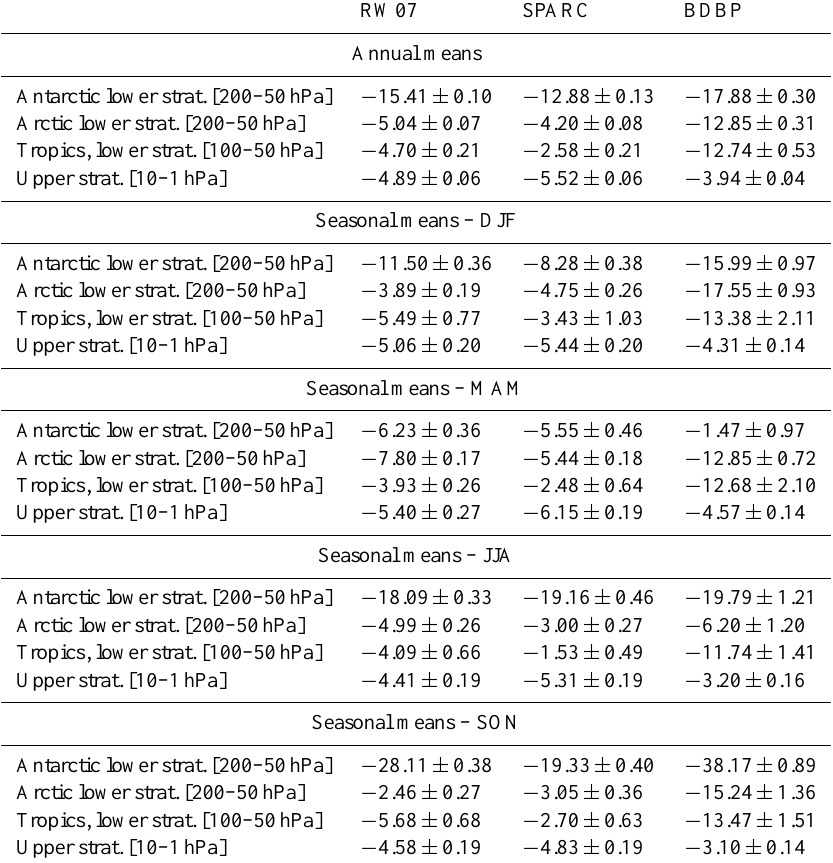
Table 2. Annual and seasonal mean ozone trends and their 1 σ uncertainty for the three different data sets for four different atmospheric regions. Trends are given % per decade and are calculated for the time period 1979 to 1996. Antarctic region: 90 ◦ S to 70 ◦ S;